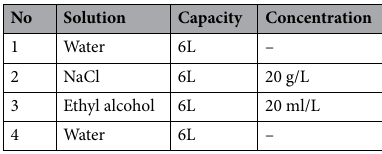
Table 1. The characteristics of leachate.